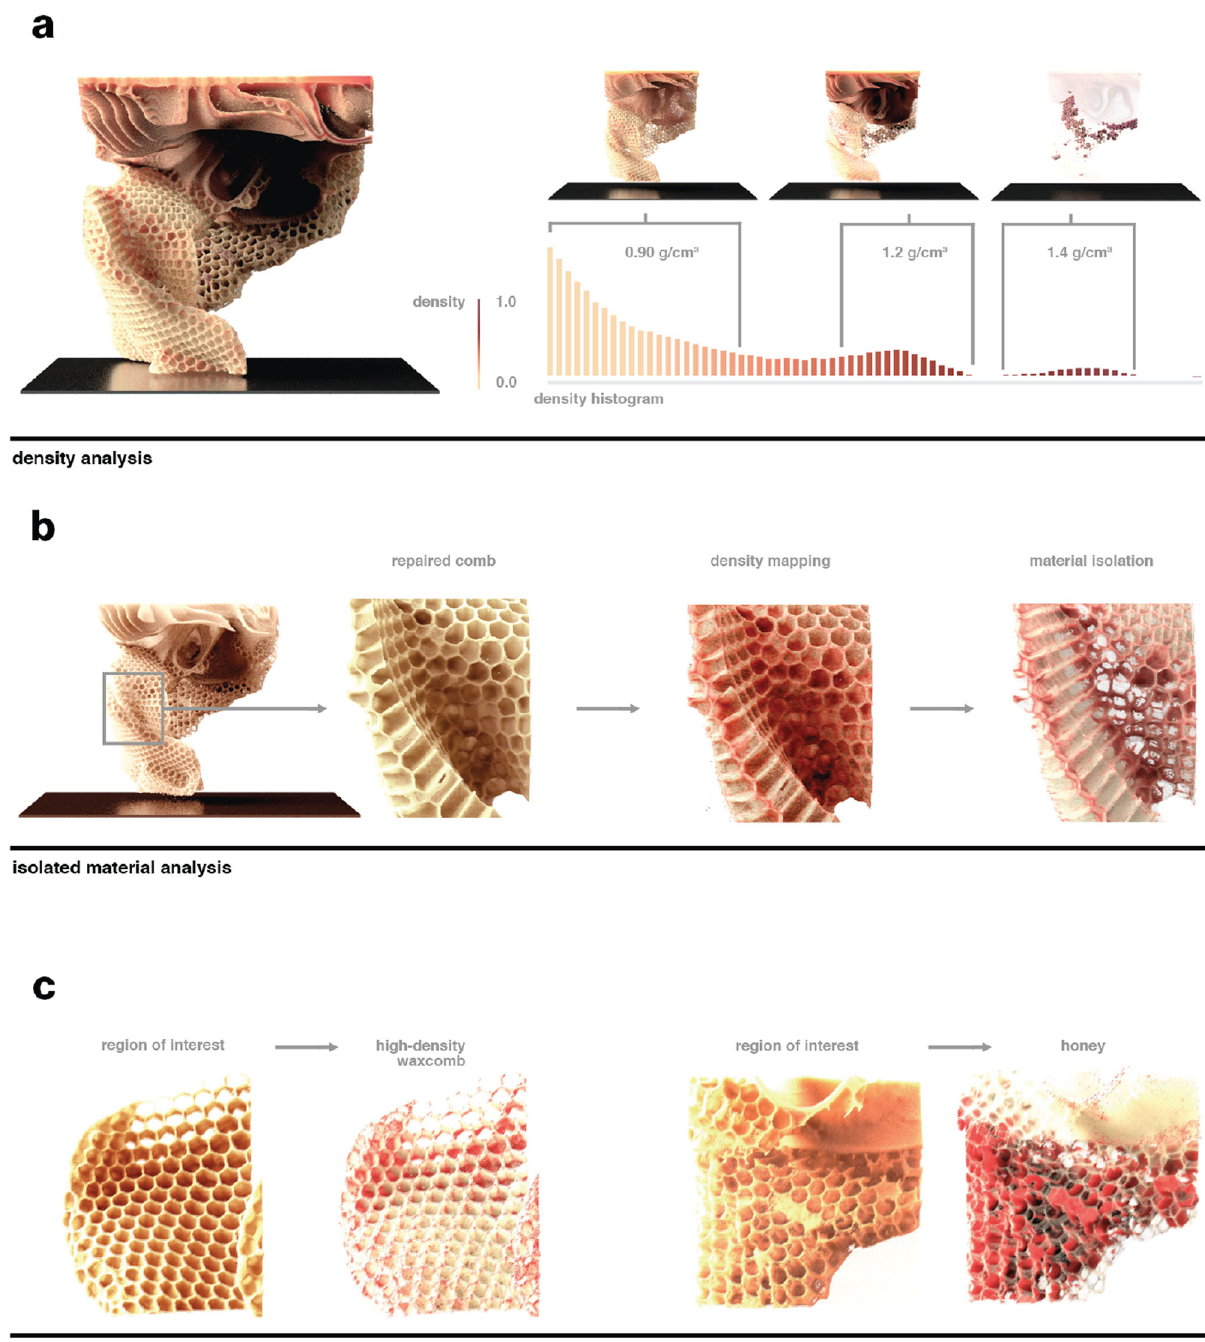
Fig. 7 Attenuation contrast-based fi ltering and identi fi cation of speci fi c material distributions. a Density analysis of a scanned comb (Hive F, Fig. S2) was applied to measure speci fi c materials within a comb built on a 3D-printed substrate. The measured density values from the micro-CT scan data can be extrapolated to physical density measurements by identifying materials with measured densities within the scan. b Once real densities have been mapped, an isolated region of the hive where the broken comb was repaired by the colony was isolated and examined, suggesting that a higher-density wax was allocated to the fractured region and the comb ’ s interface. c This method was used to examine distributions of low- and high-density wax throughout the hive as well as to measure the volume of honey in capped